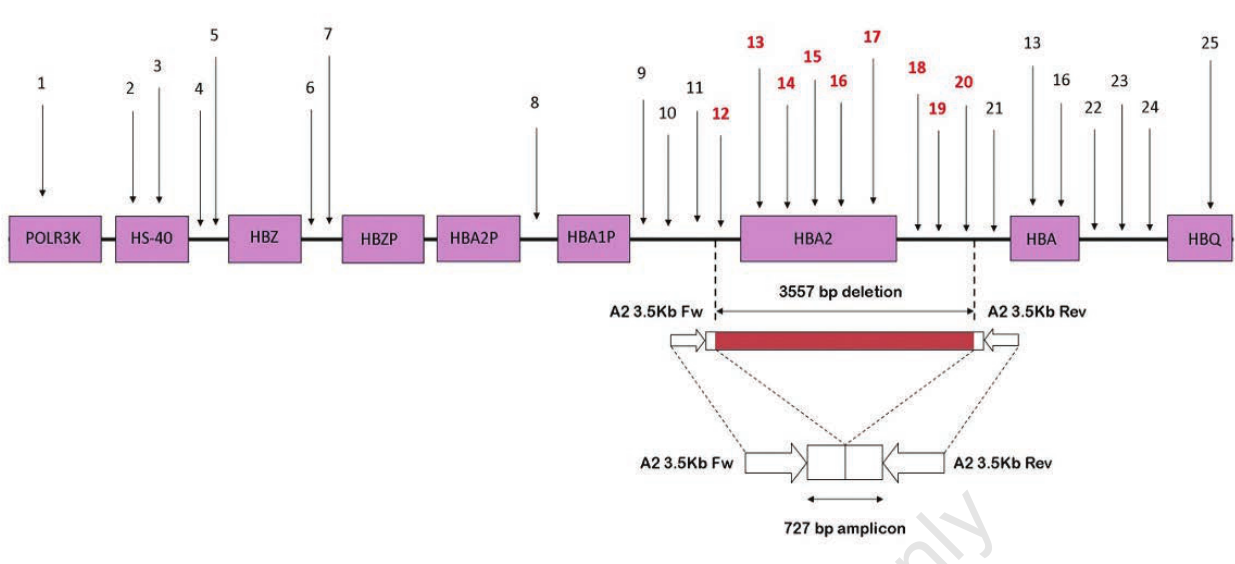
Figure 1. The multiplex ligation dependent probe amplification (MLPA) probes were scattered along the a -globin gene cluster. MLPA result for ( a MAL3.5 ) deletion shows reduced probe ratios spanning from probe 12 (MLPA probe 04628-L04008) to probe 20 (MLPA probe 08494-L08417). The primers (A2 3.5 kb Fw and A2 3.5 kb Rev) were used to amplify the sequences across the deletion break- ‒ point. The amplicon with size of 727 bp was sent for direct sequencing to identify the deletion breakpoint. The deletion was 3557 bp in size, which deletes the whole HBA2 gene but leave the HBA1 gene intact.